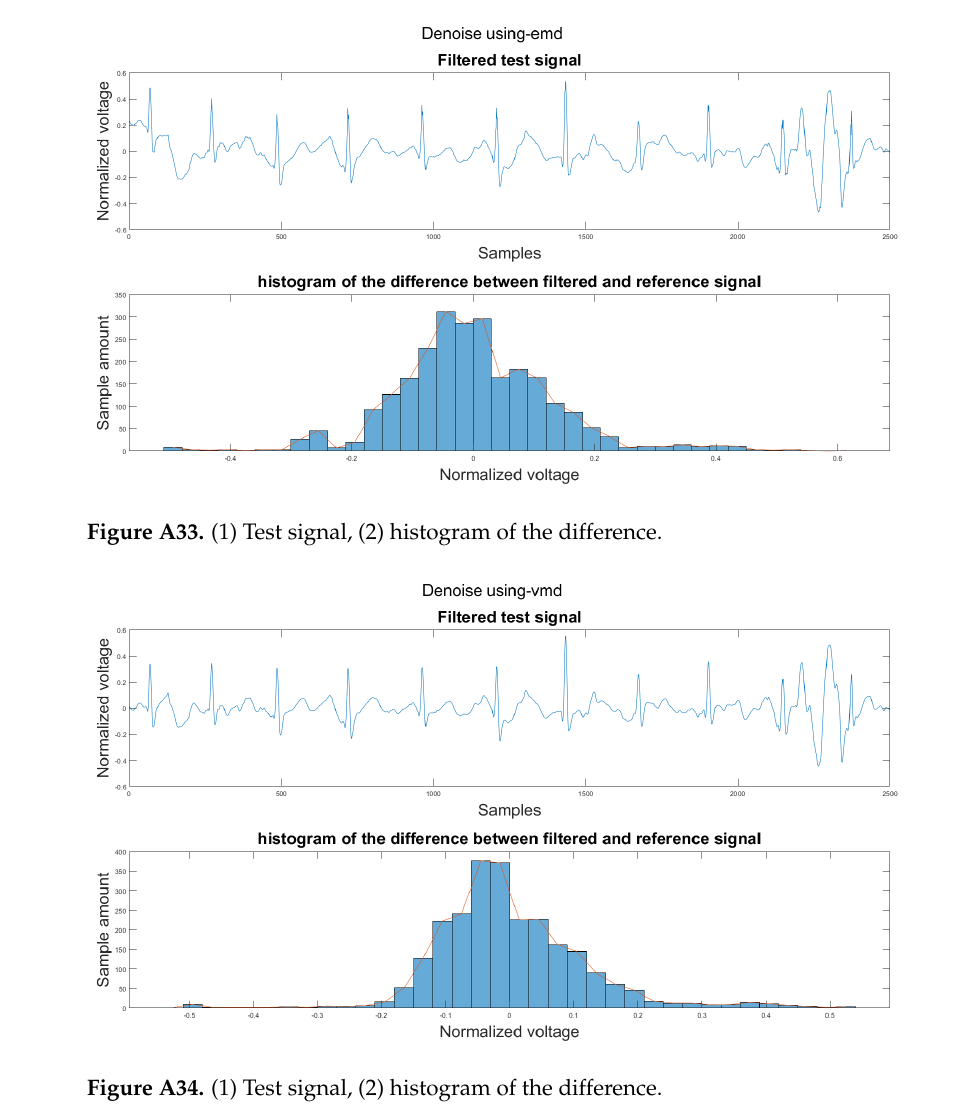
Figure A34. (1) Test signal, (2) histogram of the difference.